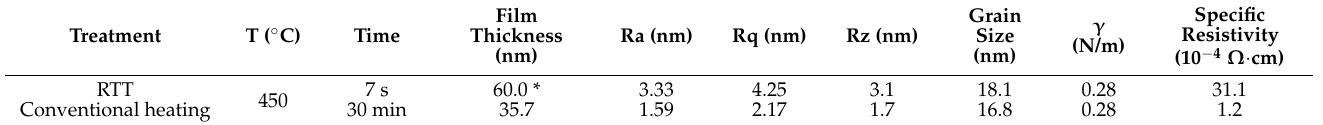
Table 1. Comparison of the CrSi 2 layer properties obtained by RTT and conventional heating. Treatment